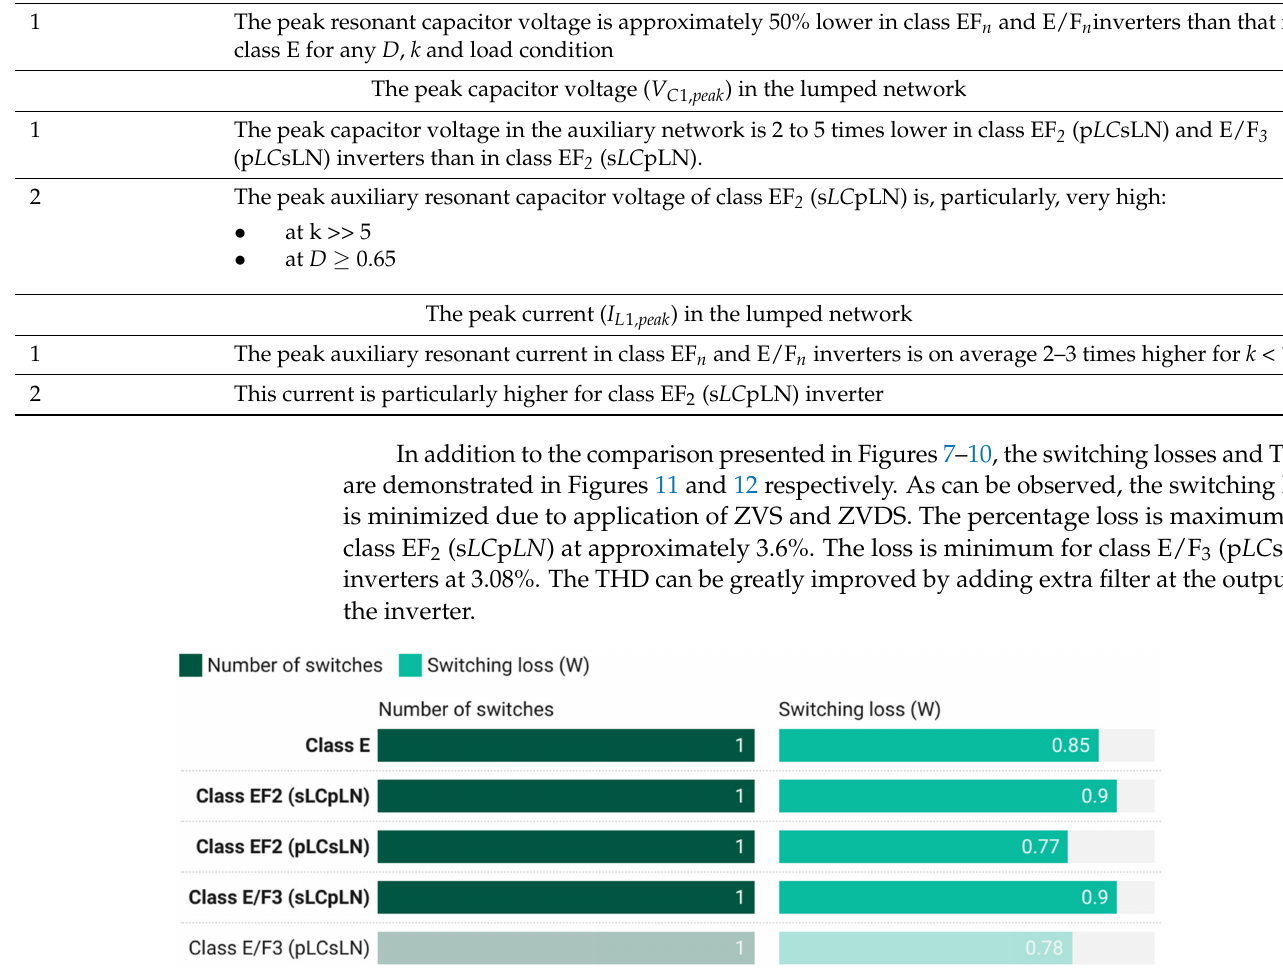
Figure 11. The switching loss in the class E and enhanced class E